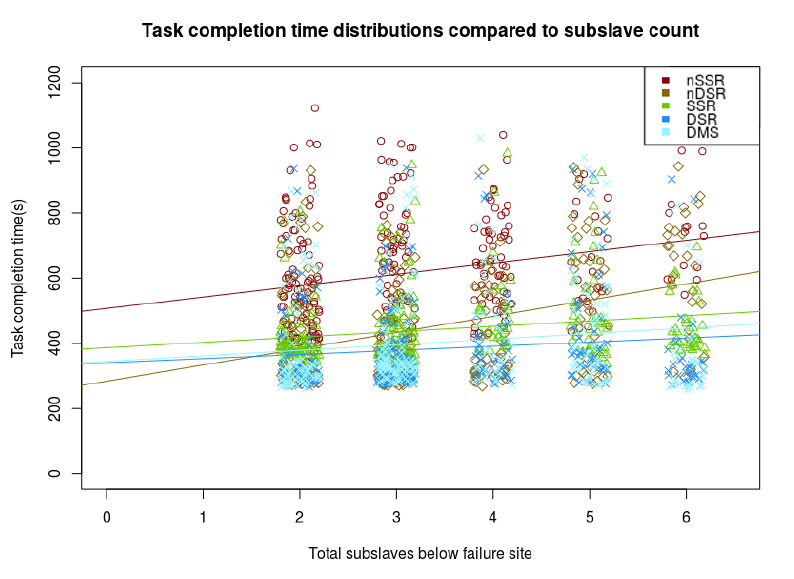
Figure 14. Datapoints from all structure and failure scenarios, excepting those that timed out before completion, showing how the performance of each of the four strategies varies with the number of subslaves docked below the failed module in the structure’s hierarchy. The naive-breakup-based strategies exhibit stronger Pearson correlation coefficients than the self-repairing strategies; for nSSR, nDSR, SSR, DSR and DMS, respectively, these are 0.25, 0.34, 0.19, 0.11 and 0.13. For graphical clarity, a random sample of datapoints were hidden and left–right jitter was applied; lines of best fit are still derived from full unjittered datasets.